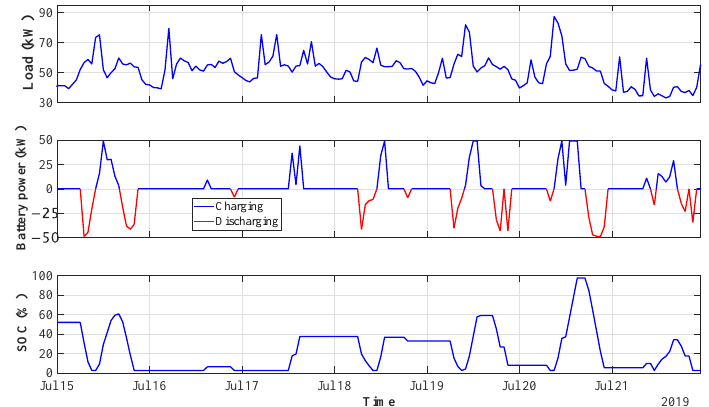
Figure 14. Marina’s load and BESS for the future scenario.